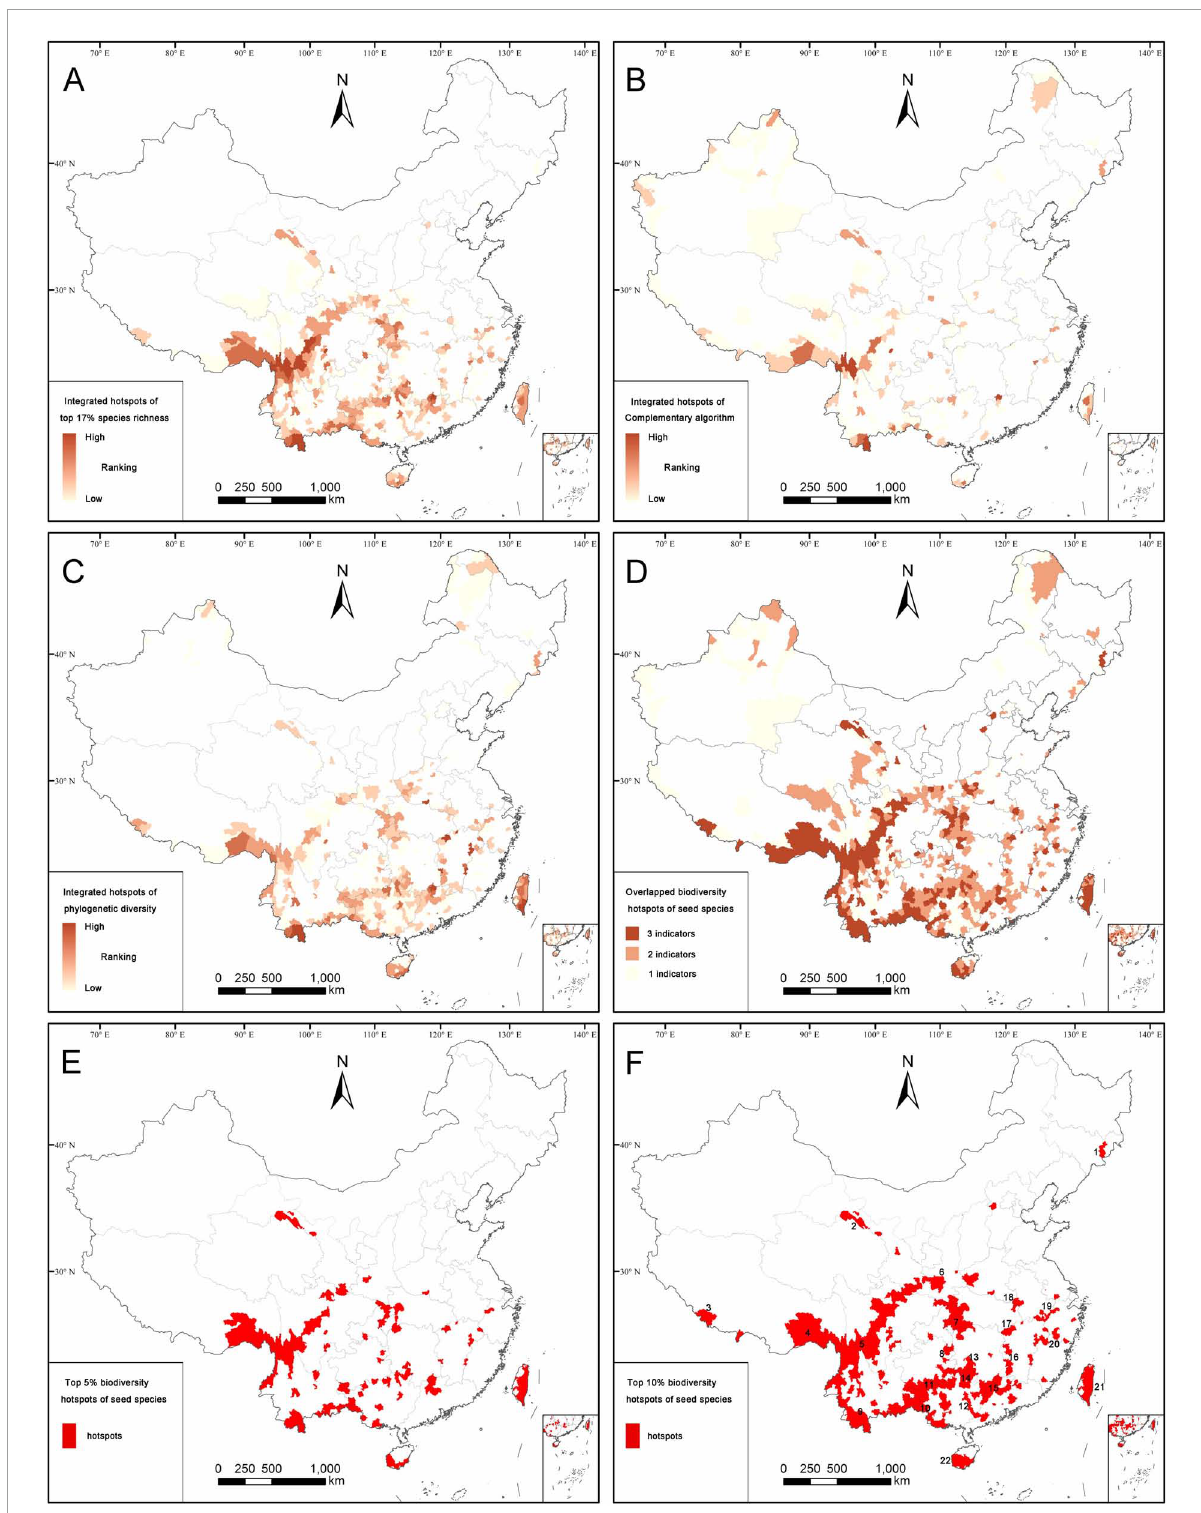
FIGURE4 Distribution patterns of the integrated hotspot counties according to the species richness algorithm (A) , complementary algorithm (B) , spatial phylogenetics (C) , the overlapping hotspot counties identified by two or three algorithms (D) , top 5% (E) , and top 10% (F) biodiversity hotpots. The top 10% biodiversity hotspots (F) are defined as final biodiversity hotspots including 22 hotspot areas, viz. (1) Northern part of Changbai Mountain, (2) Qilian Mountain, (3) Nielamu region, (4) south-eastern part of Xizang, (5) Hengduan Mountains, (6) Qinling Mountains,